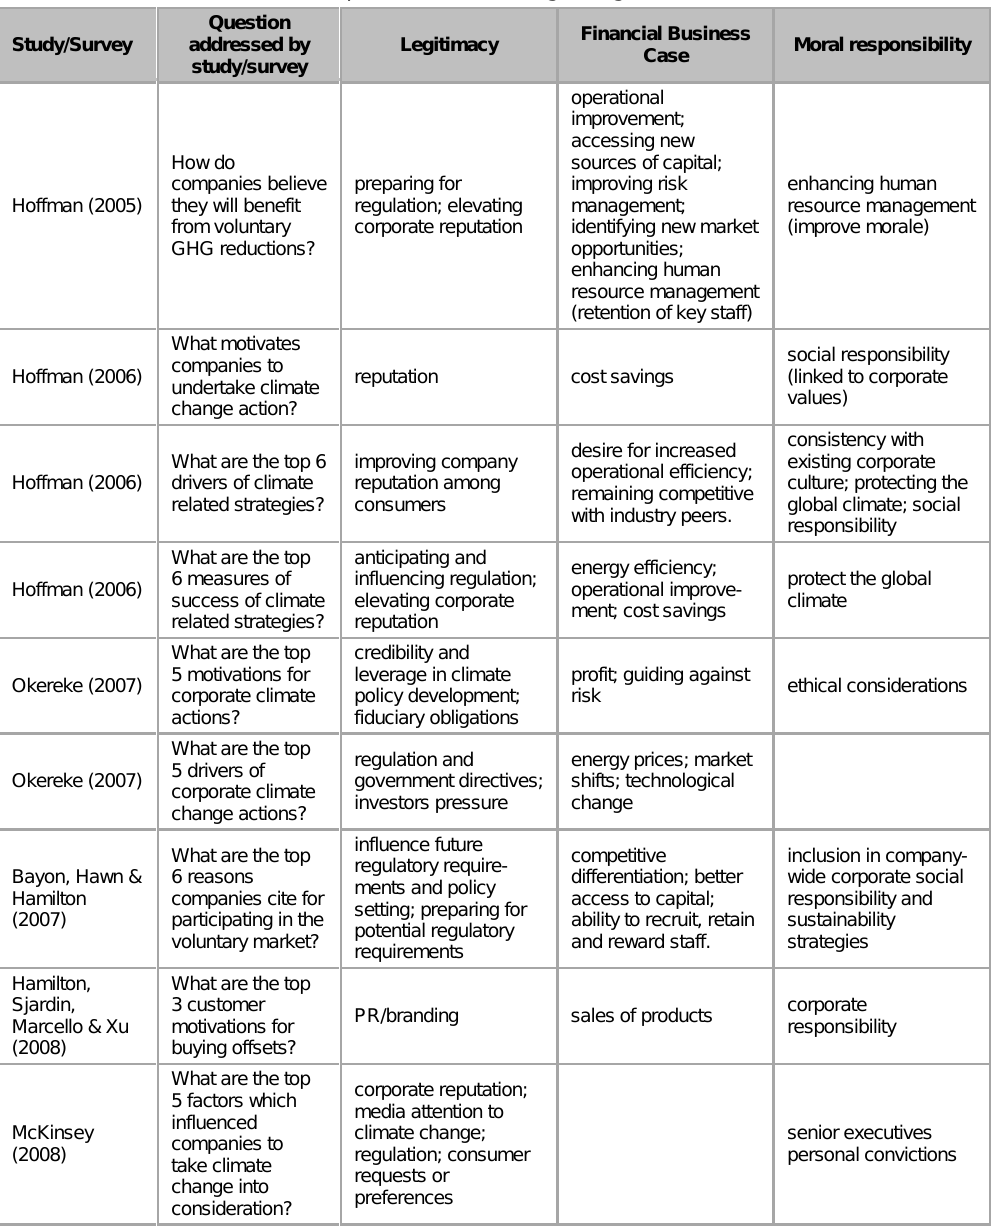
Categorisation of key motivational factors identified in previous surveys and studies